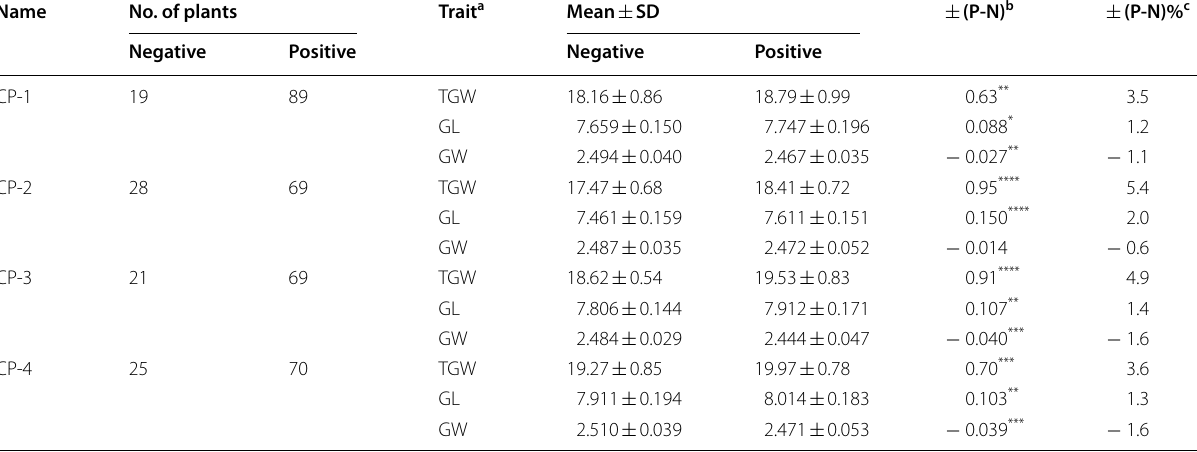
Table 1 Genetic effects of OsPUB3 in four transgenic complementation populations